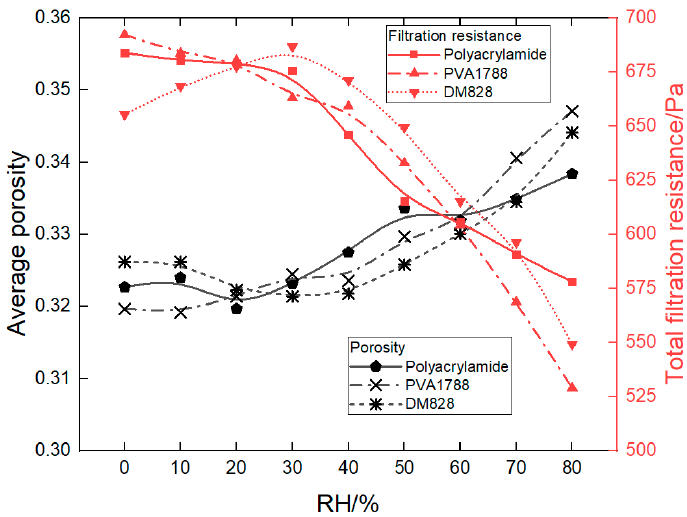
Figure 7. The effect of the relative humidity on the average porosity and the total filtration resistance of the three filter cakes.